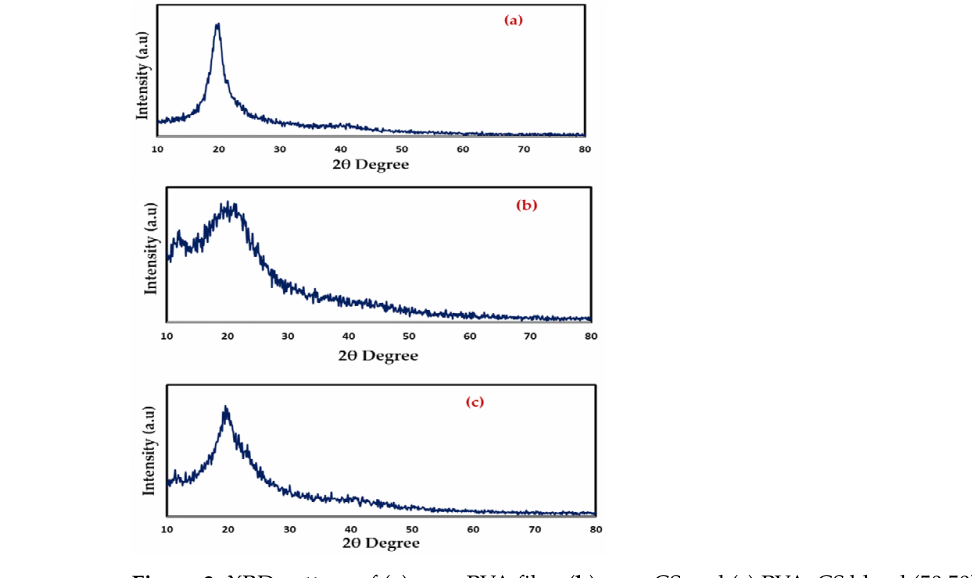
Figure 3. XRD pattern of ( a ) pure PVA film, ( b ) pure CS and ( c ) PVA: CS blend (50:50) films.